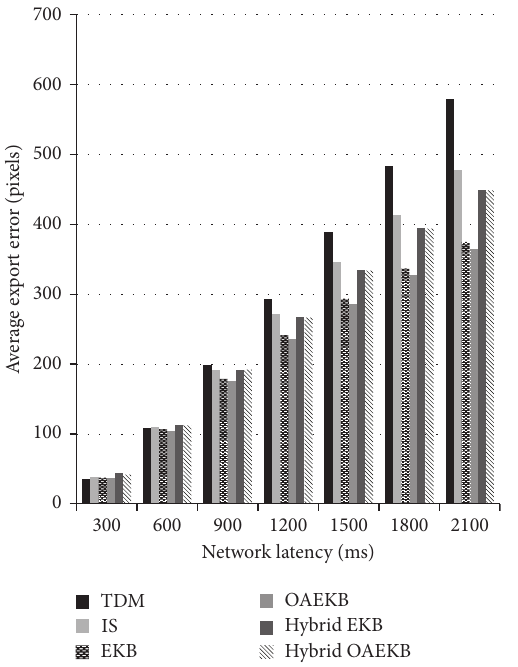
Figure 10: Average export error comparison. Table 6: Hit percentages at threshold 𝑔 = 45 .